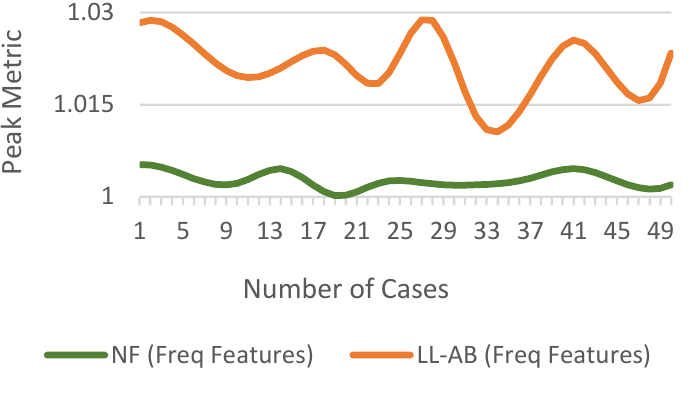
Figure 8. PM of Freq for fault and NF